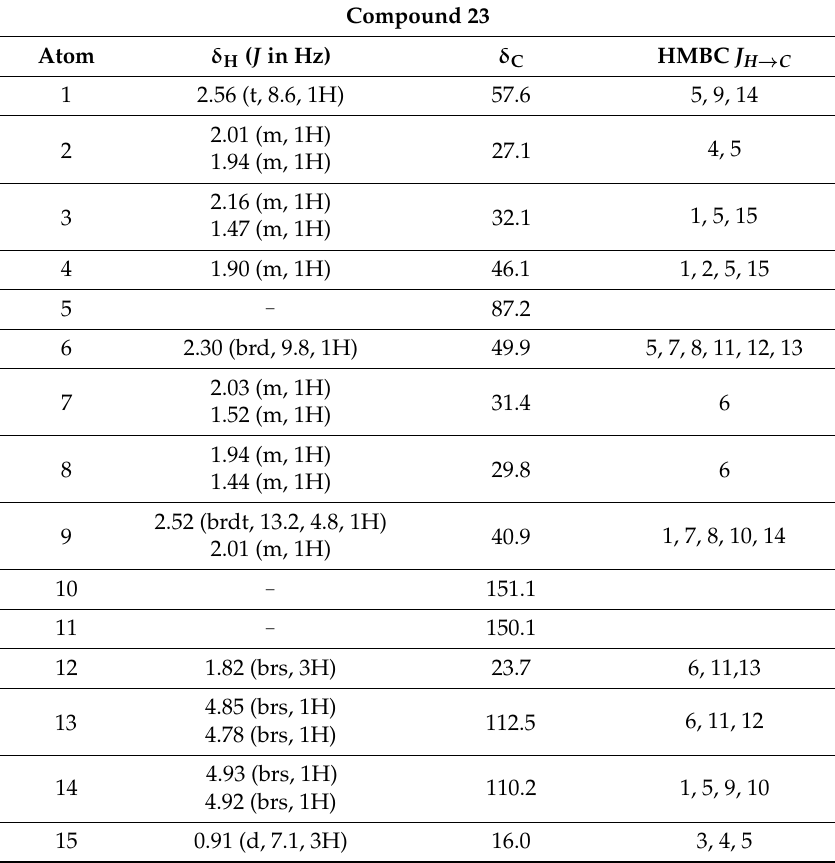
Table 1. NMR data of compound 23 in CDCl 3 at 300 K ( 1 H at 500 MHz, 13 C at 125 MHz).